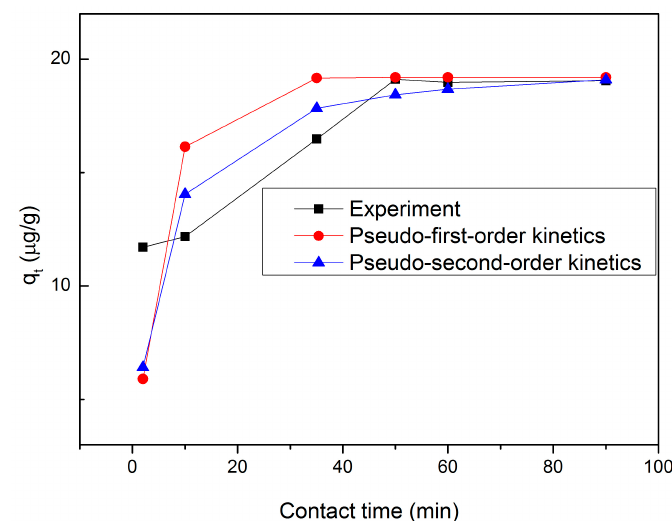
Figure 5. Time-dependent study of Hg ions removal by Fe 3 O 4 /rGO composites (initial pH = 7.0; Fe 3 O 4 /rGO dosage = 20 mg; temperature = 25 ◦ C; Hg ions concentration = 10 µ g/L). Table 3. Kinetic parameters for the removal of the Hg ions by the Fe 3 O 4 /rGO composites. Model